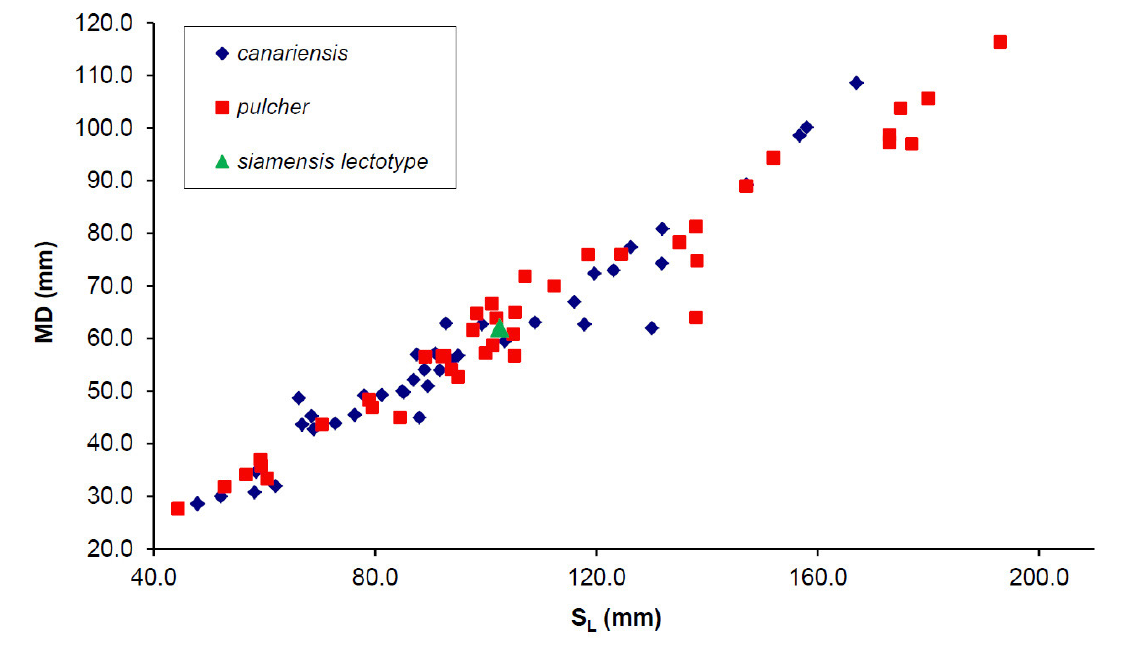
Fig. 8. Plot of maximum diameter (MD, mm) versus shell length (S (  ) and K. pulcher ([Lightfoot], 1786) (  ). The lectotype of K. siamensis (Hwass in Bruguiére, 1792) (  ) is also